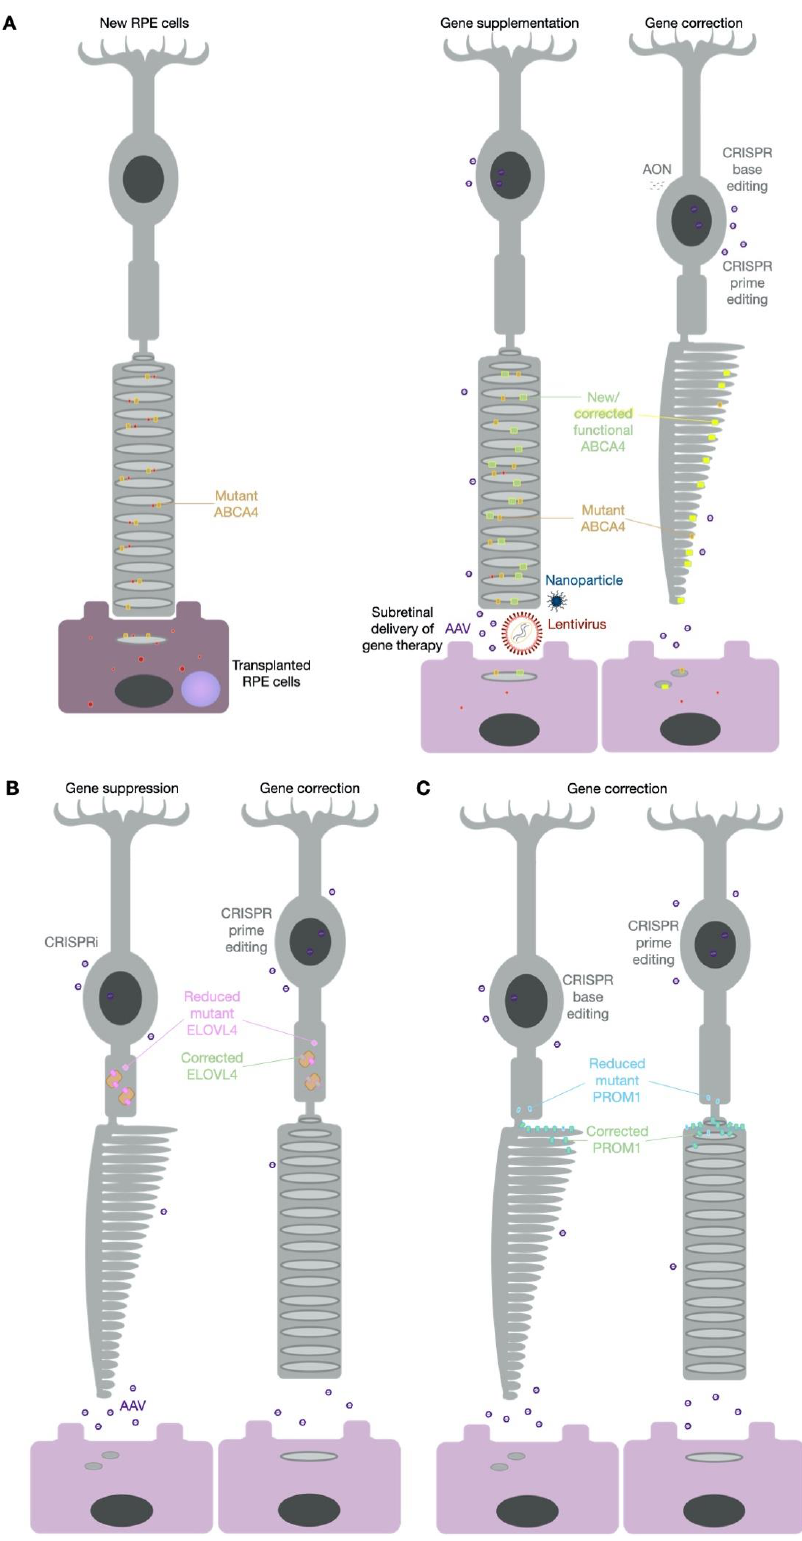
Figure 3. Comparisons of therapy strategies for Stargardt disease. Transplantation of RPE cells has been performed in STGD1 patients with gene supplementation and CRISPR-based genome-editing vectors as future treatment options ( A ). Therapies for STGD3 ( B ) and STGD4 ( C ) will likely focus on CRISPR-based